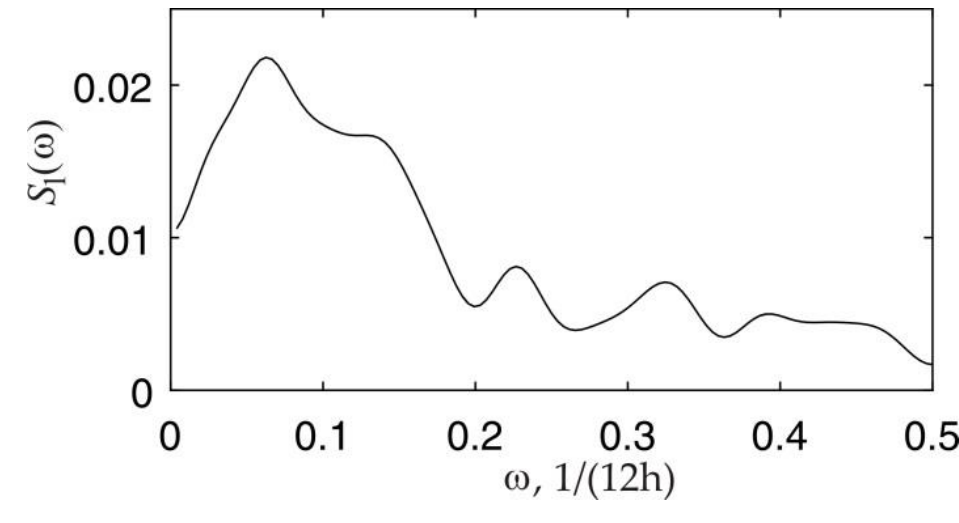
Figure 4. Sample spectrum of the process e t, 1 .